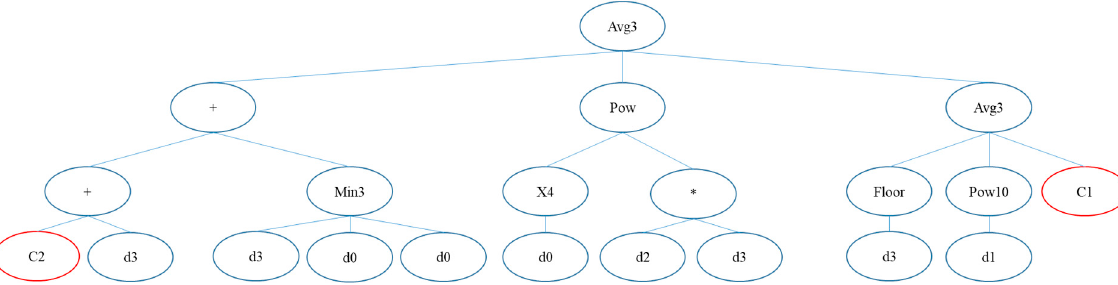
Figure A2. Sub-ET2 of GEP bathymetry retrieval model.